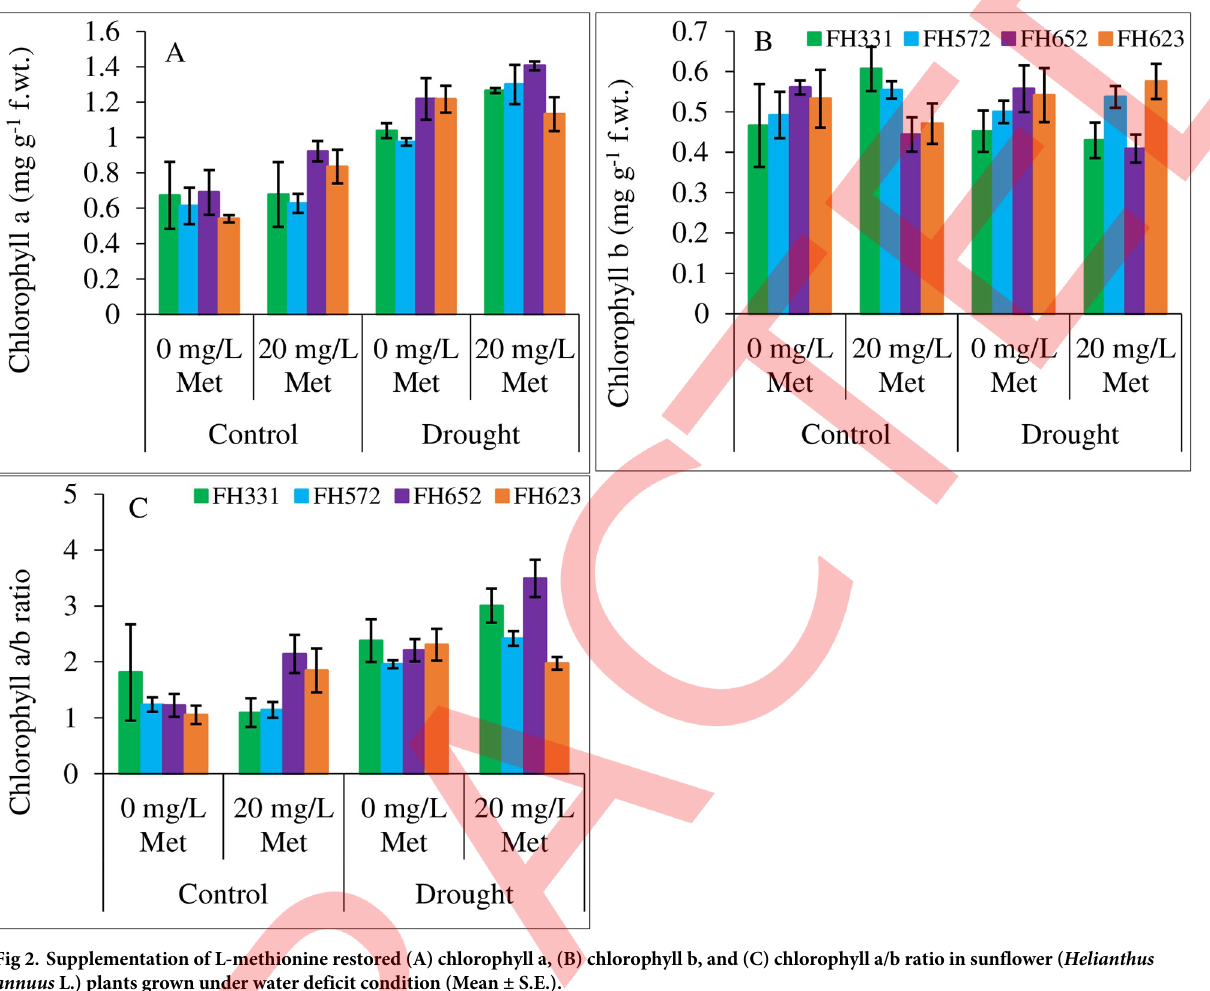
watering regimes (Table 1; Fig 5A and 5B). Of all sunflower cultivars, cvs. FH331 and FH623